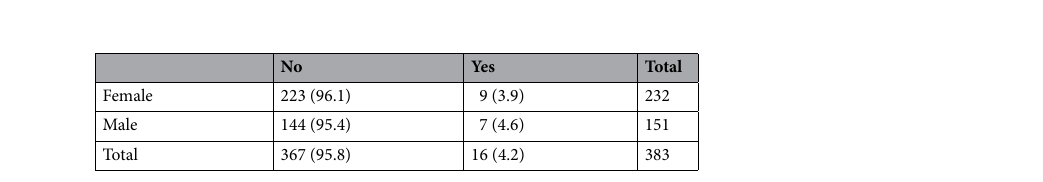
Table 2. FCRB distribution on left upper-extremity MR images [n (%)]. FCRB musculus flexor carpi radialis brevis, MR magnetic